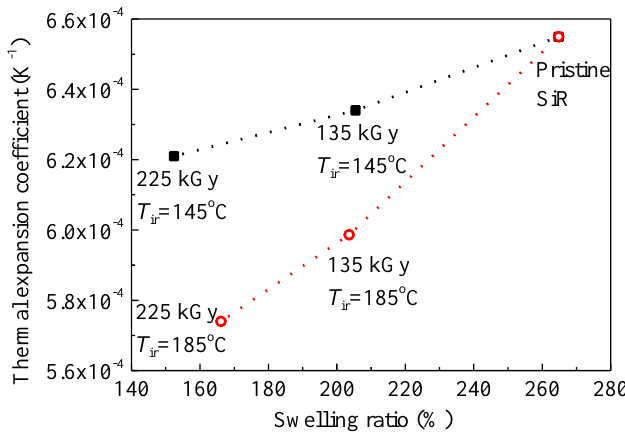
Figure 9. Thermal expansion coefficient as a function of swelling ratio at T ir of 145 and 185 °C.